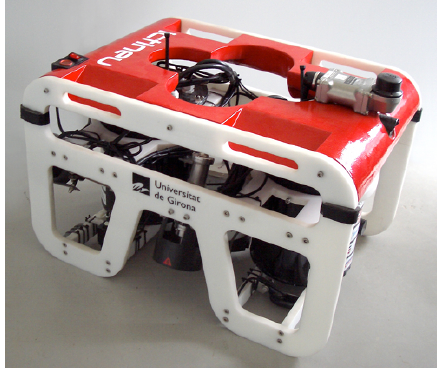
Figure 4. The Ictineu AUV, developed in the University of Girona. (Source: http://cirs.udg.edu/).